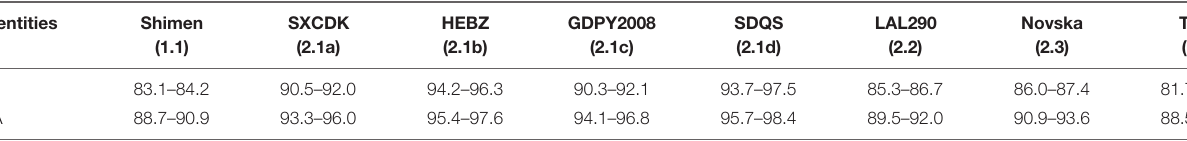
TABLE 2 | Nucleotide (nt) and AA identities of E2 gene between the 25 new isolates and other eight representative CSFV isolates (%). Identities